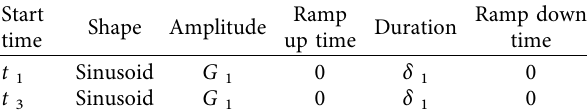
Table 3: Gradient pulses along the x